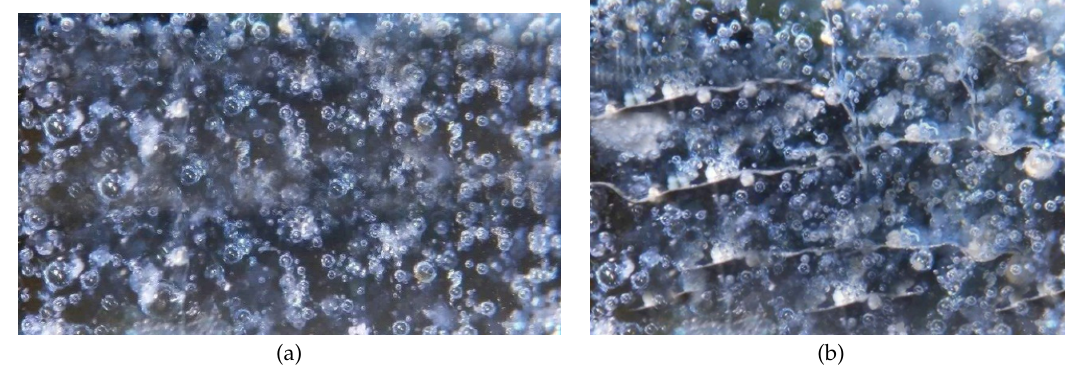
Fig. 5. The comparisons of scanning image of rock structure before and after the intrusion; (a)Scanning image of rock structure surface before intrusion; (b)Scanning image of rock structure surface after